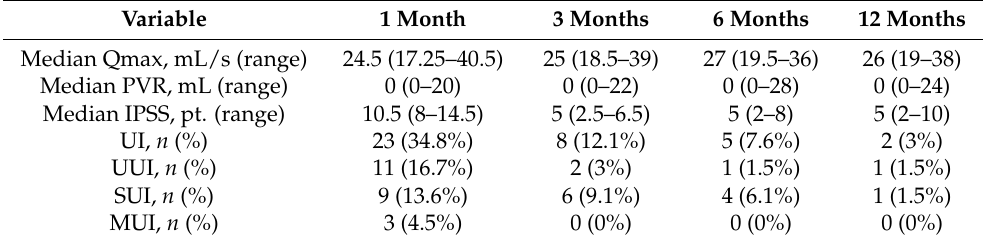
Table 4. Functional outcomes.